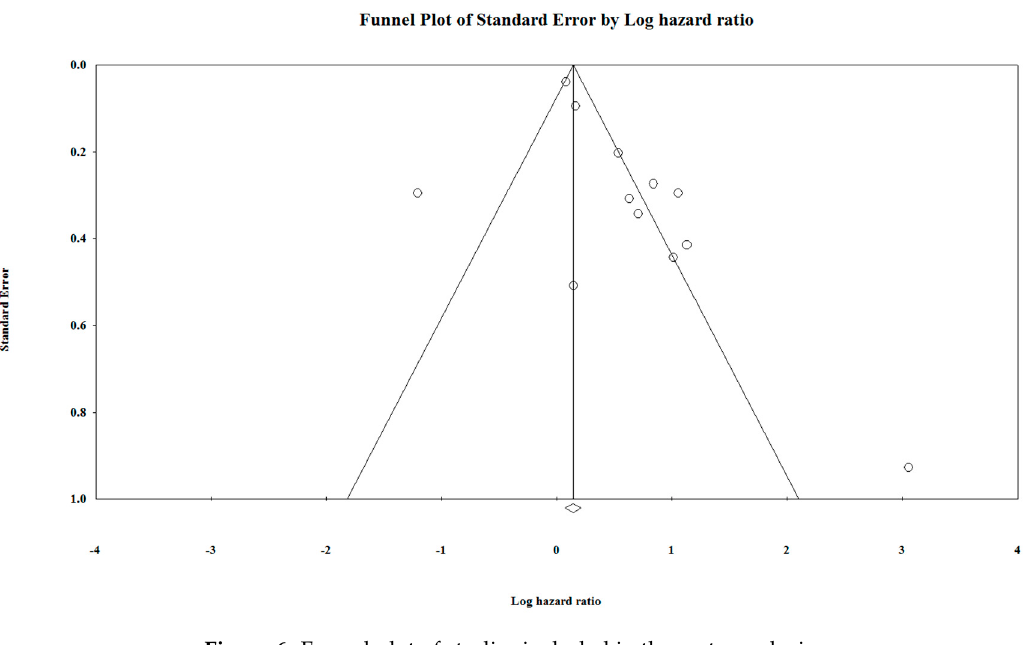
Figure 6. Funnel plot of studies included in the meta-analysis.